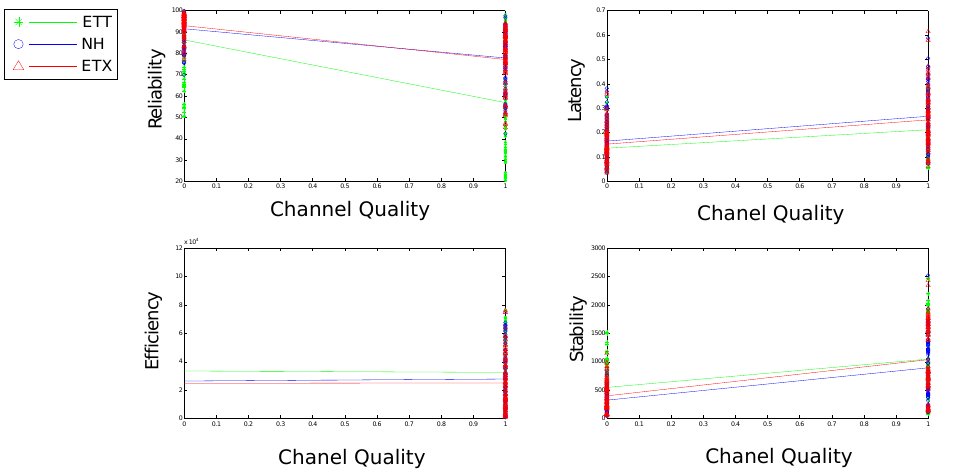
Figure 13. Network response from each solution as quality